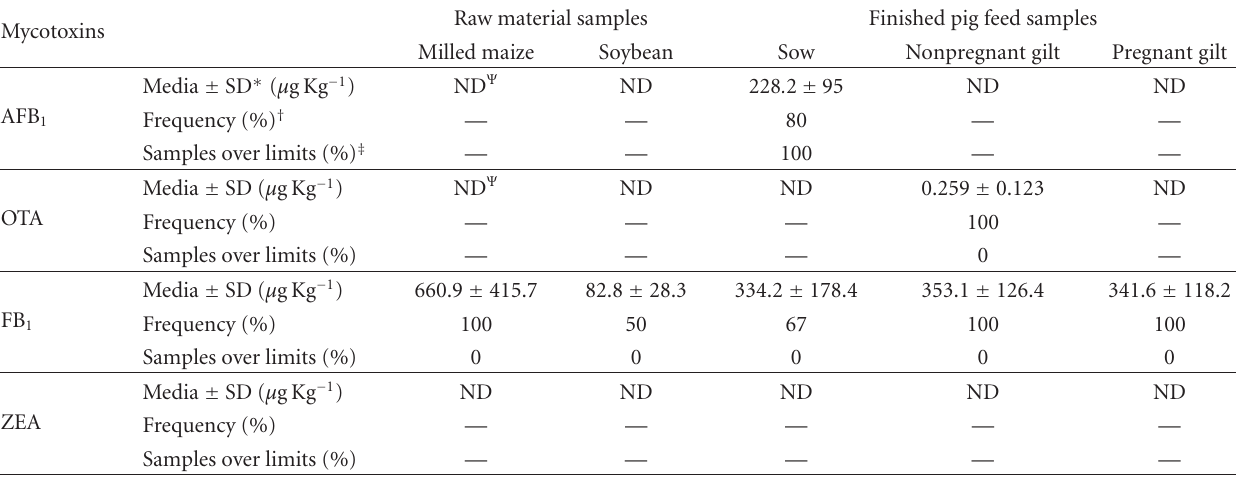
Samples over limits (%)